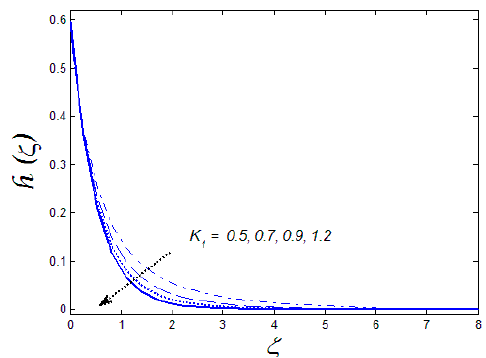
Figure 5. Upshot of K 1 on temperature profile θ ( ζ ) .